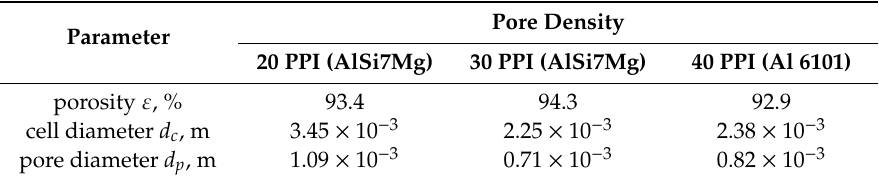
Table 1. Characteristics of aluminum foams.